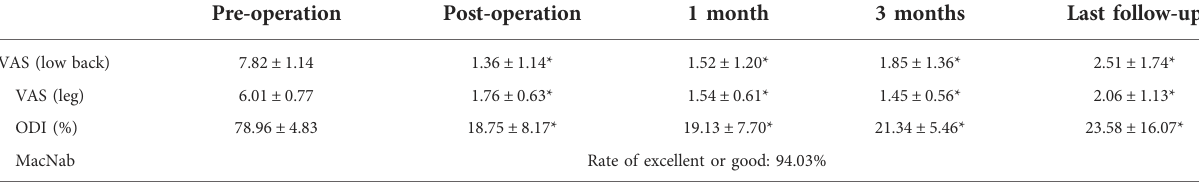
TABLE 4 Clinical outcomes before and after